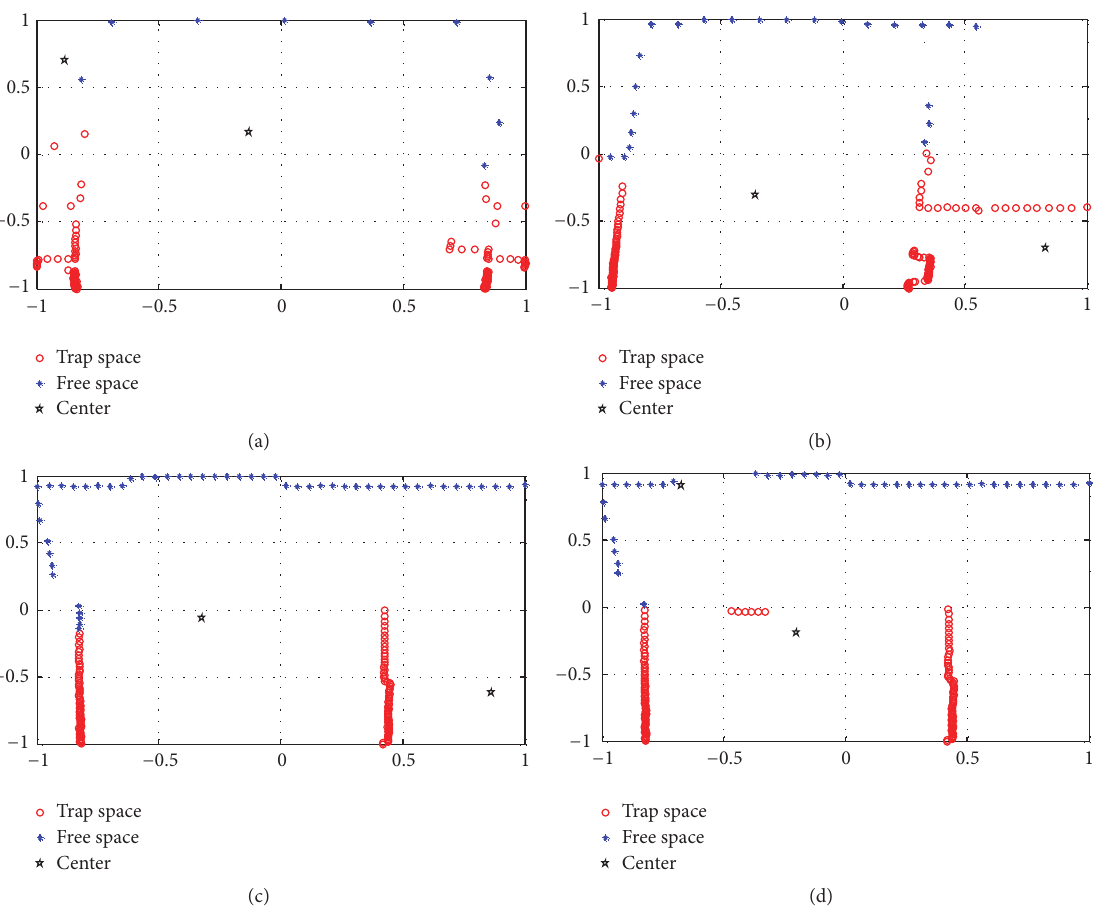
Figure 12: Result of space identification at (a) position A, (b) position B, (c) position C without a barrier in the corner, and (d) position C with an obstacle in the corner.